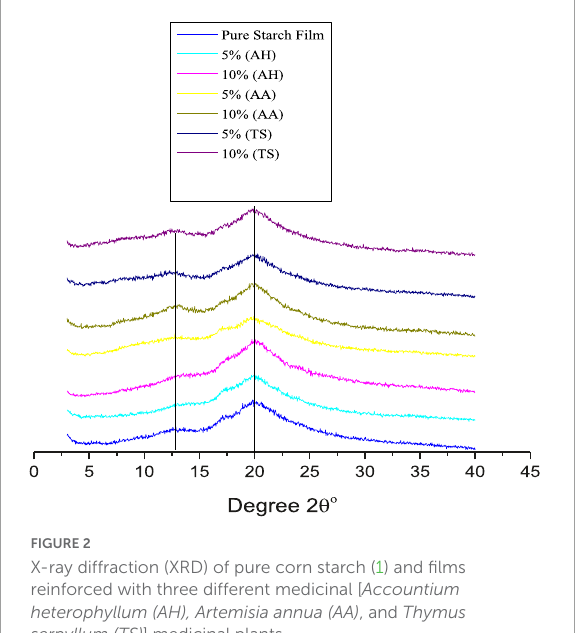
FIGURE2 X-ray diffraction (XRD) of pure corn starch (1) and films reinforced with three different medicinal [ Accountium heterophyllum (AH), Artemisia annua (AA) , and Thymus serpyllum (TS) ] medicinal